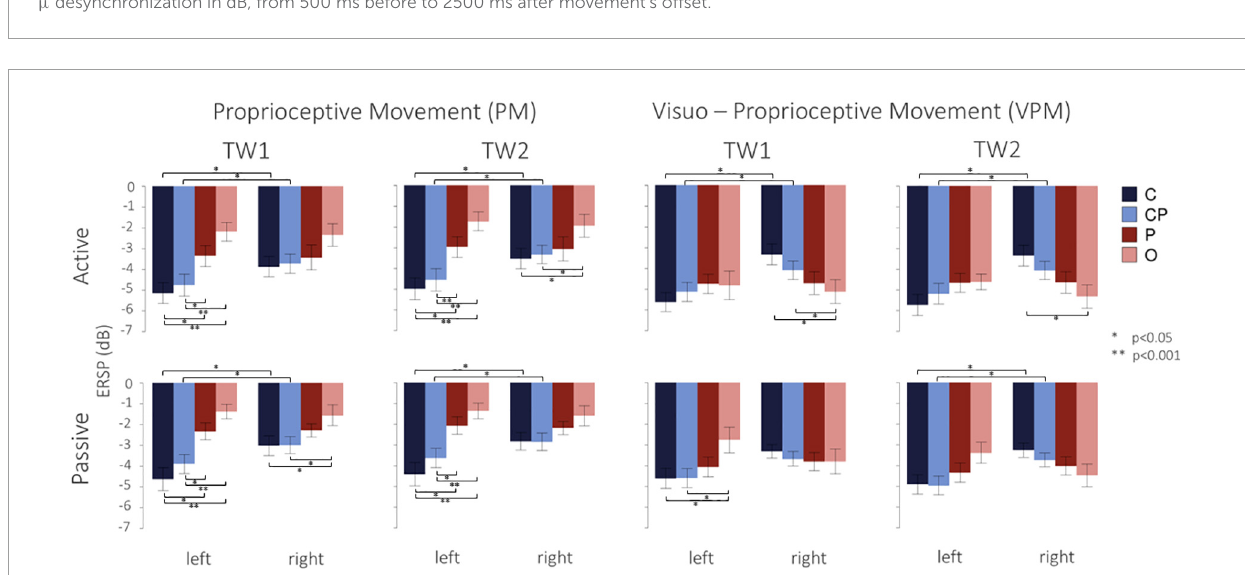
FIGURE5 Mean and standard errors of ERSP values (dB) in the two conditions (PM and VPM) during active and passive movements ( top and bottom line). Different colors indicate the four ROIs analyzed in the left and right hemispheres. Indicate a significant (* p < 0.05) and highly significant (** p < 0.001) difference, respectively, after Bonferroni’s